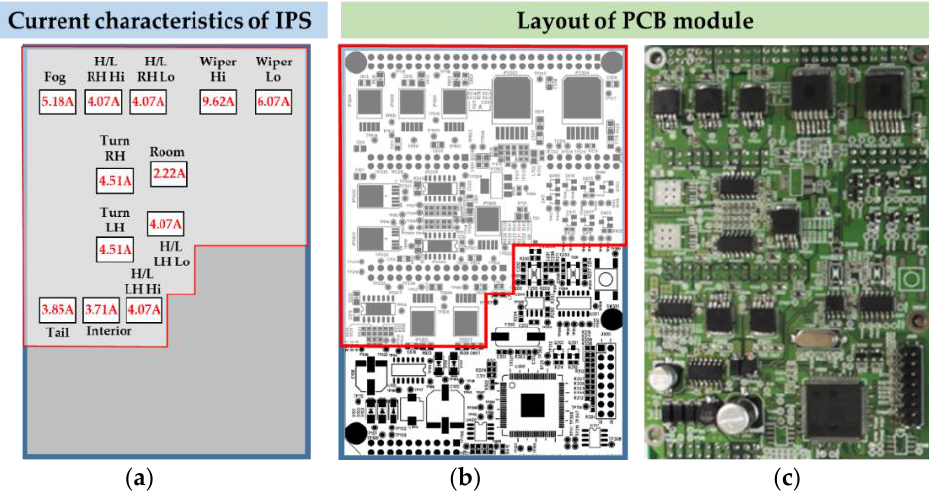
Figure 6. Diagrams showing the PCB layout of the SJB: ( a ) block diagram of the IPS circuitry, ( b ) arrangement of the components on the board, with the IPS circuitry contained within the area outlined in red and the control circuitry contained in the lower region, and ( c ) photographic image of the fabricated PCB.